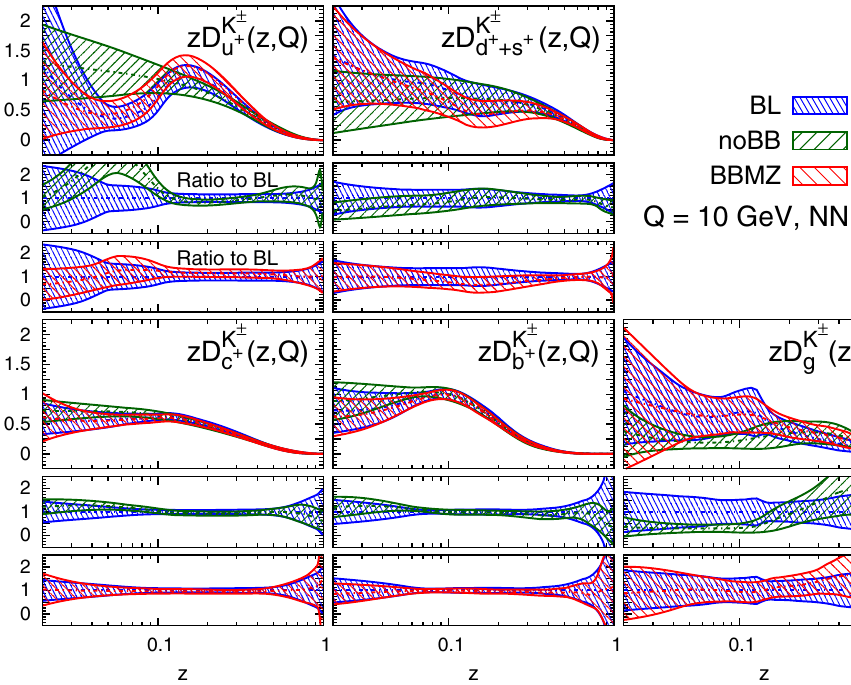
Fig. 21 Same as Fig. 20, but for the sum of charged kaons, K ±